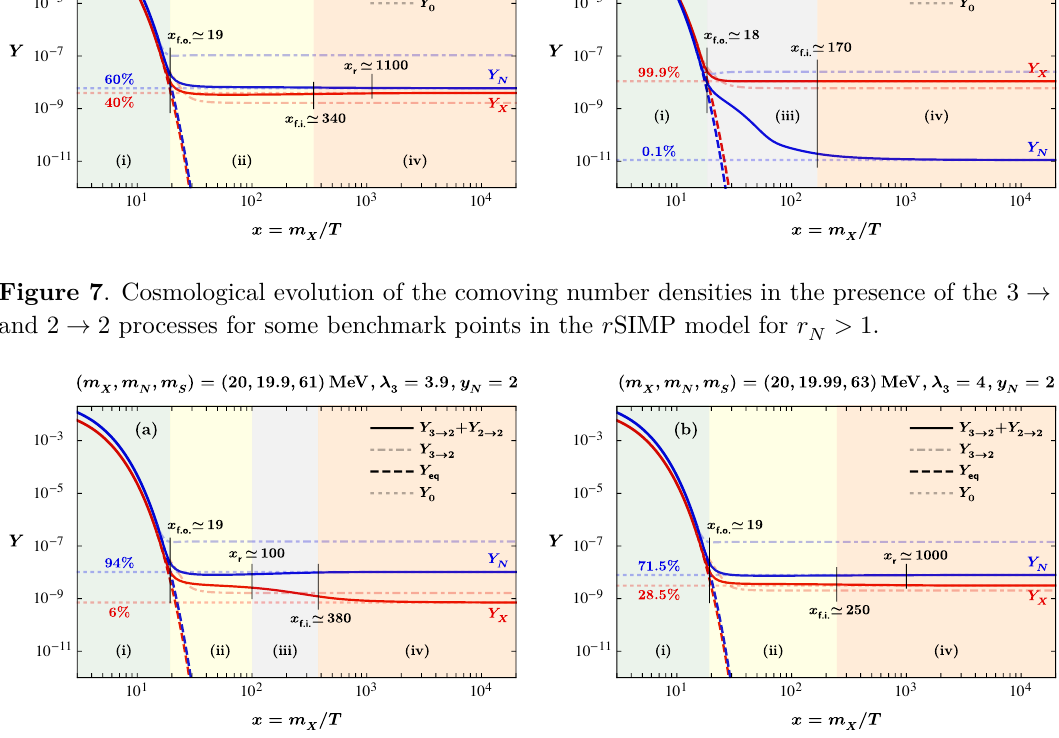
Figure 8 . Cosmological evolution of the comoving number densities in the presence of the 3 → 2 and 2 → 2 processes for some benchmark points in the r SIMP model for r